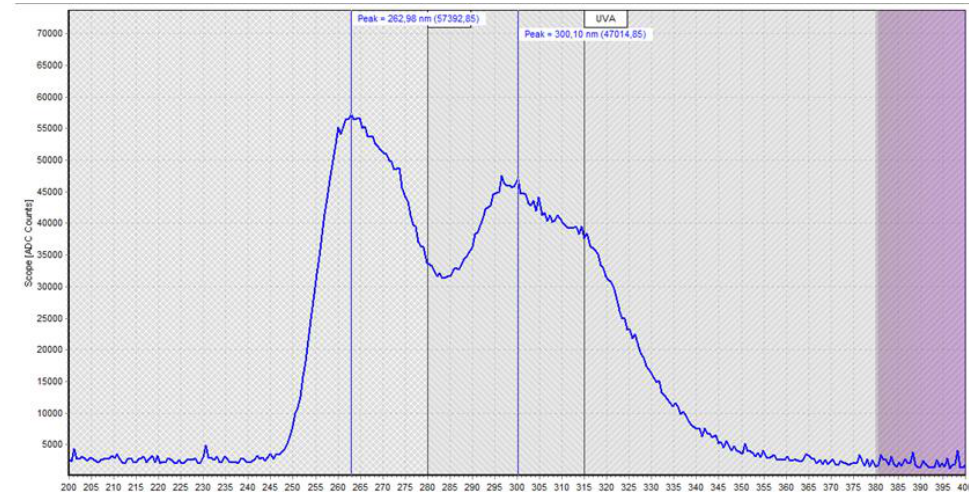
Figure 4. Photometric measurements of the light spectrum of the UV chip.